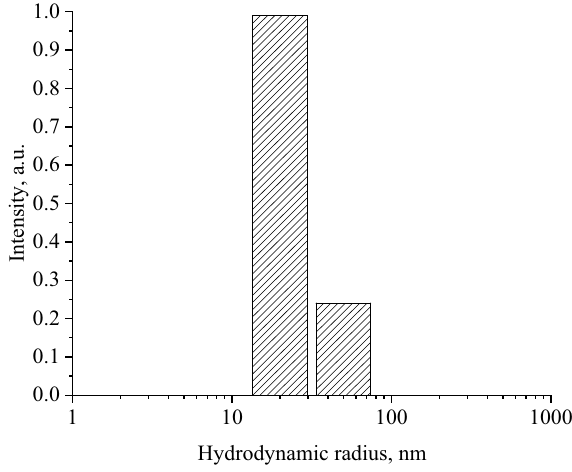
Figure 3. Histogram of the distribution of the hydrodynamic radius of Se NPs.